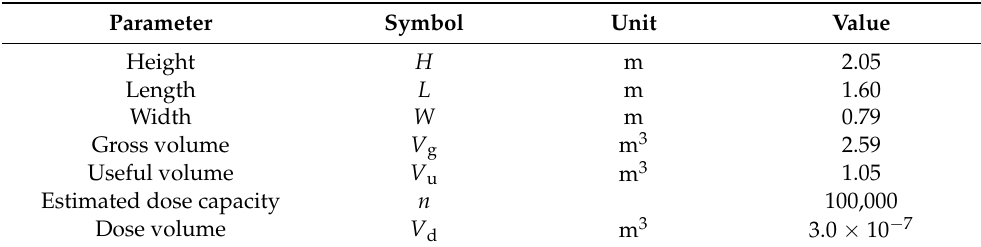
Table 2. Typical refrigerated equipment characteristics.